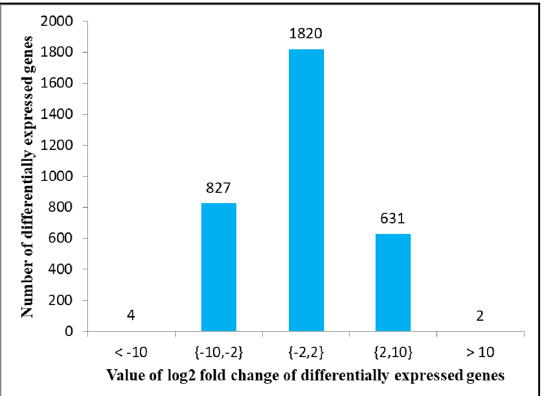
9 of 21 Figure 3. Pearson correlation coefficient heat map of gene expression between different samples. DBMA1, DBMA2, DBMA3: three biological repetitions from the susceptible strain (G88); DBMB1, DBMB2, DBMB3: three biological repetitions from the susceptible strain with toxin treatment (G88 + toxin); DBMC1, DBMC2, DBMC3: three biological rep- etitions from the resistant strain (Cry1S1000); DBMD1, DBMD2, DBMD3: three biological repetitions from the resistant strain with toxin treatment (Cry1S1000 + toxin). DEGs were then analyzed among the four treatment groups by comparing the mid- gut transcriptome. The results revealed 599, 3284, 4313, and 63 significant DEGs between